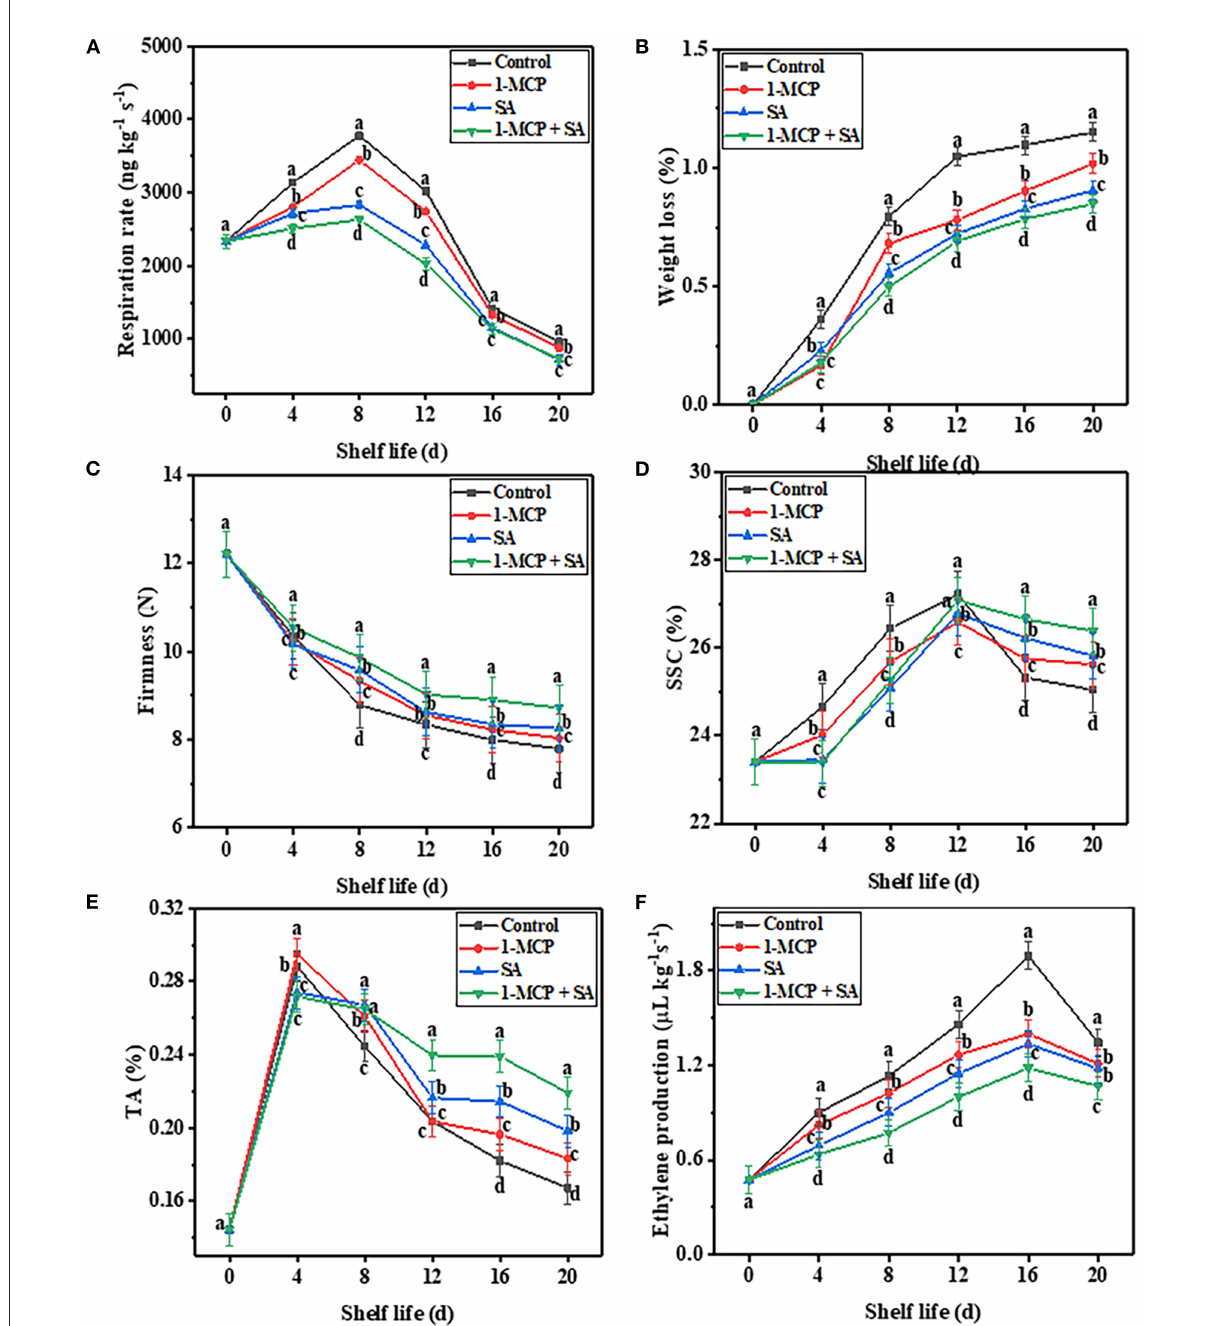
FIGURE3 Effects of 1-methylcyclopropene (1-MCP), salicylic acid (SA), and 1-MCP and SA combined treatments on respiratory rate (A) , weight loss (B) , firmness (C) , SSC (D) , TA (E) , and ethylene production (F) of winter jujube fruit during shelf life at 4 ± 1 ◦ C for 20 d. SSC, soluble solid content; TA, titratable acidity. The data presented are the mean values of three replicates; vertical bars represent the standard errors of the mean values; values followed by different superscripts (a-d) are significantly different ( P < 0.05) on the same sampling date.